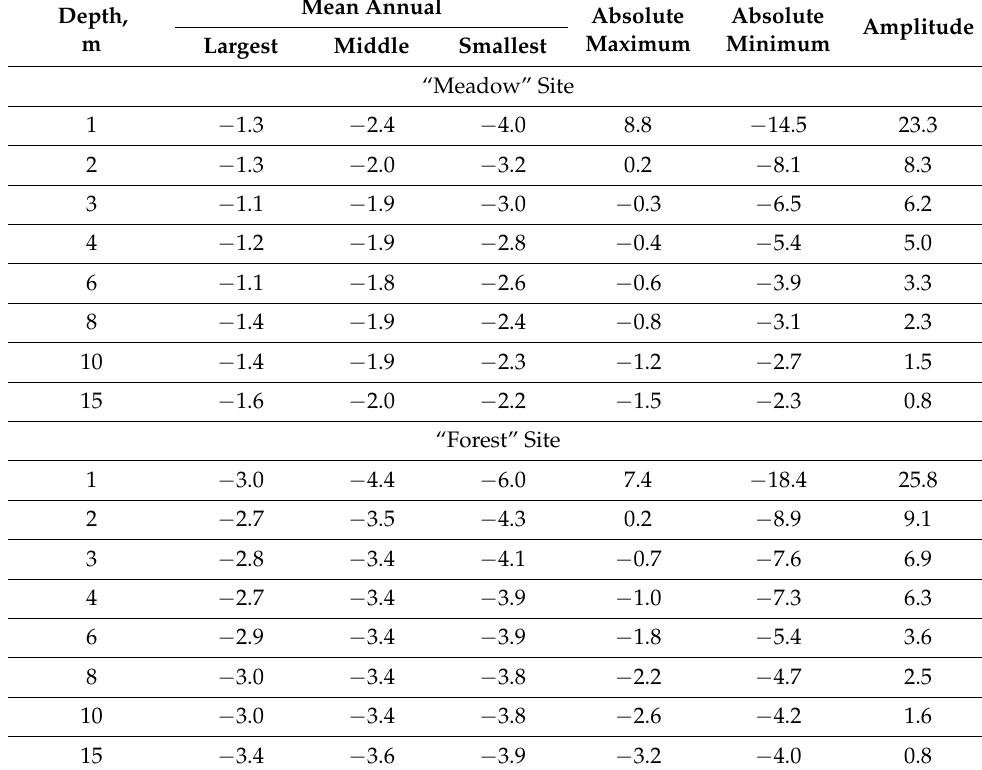
Table 3. Ground temperature at the Tuymaada station for the period 1995–2019 ( ◦ C). Depth,